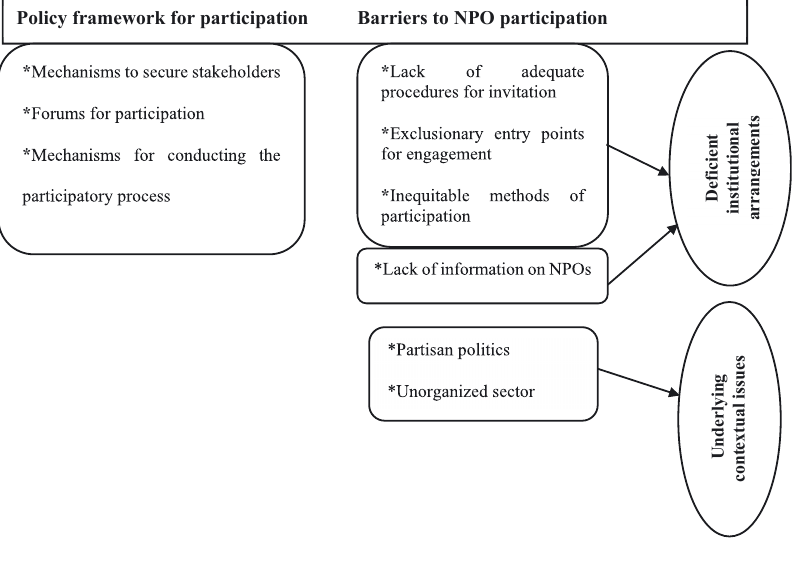
Figure 1: Barriers to NPOs participation in policy